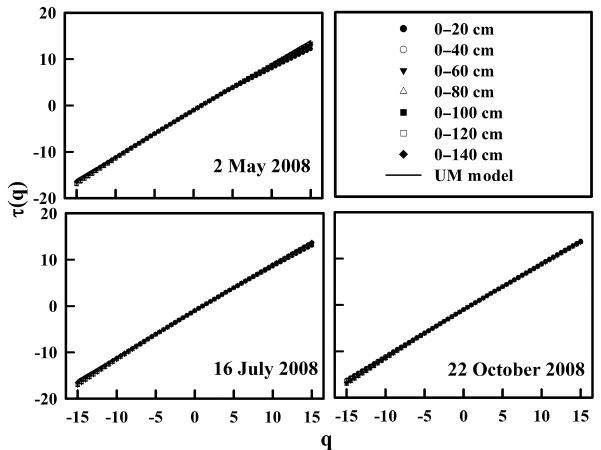
Figure 3. Mass exponents for soil water storage spatial series mea- sured at selected 20cm soil layer down to 140cm in 2008 for a range of q ( − 15 to 15 at 0.5 increments). The solid line is a linear reference created following the UM model of Schertzer and Love- joy (1987) passing through ( q = 0).